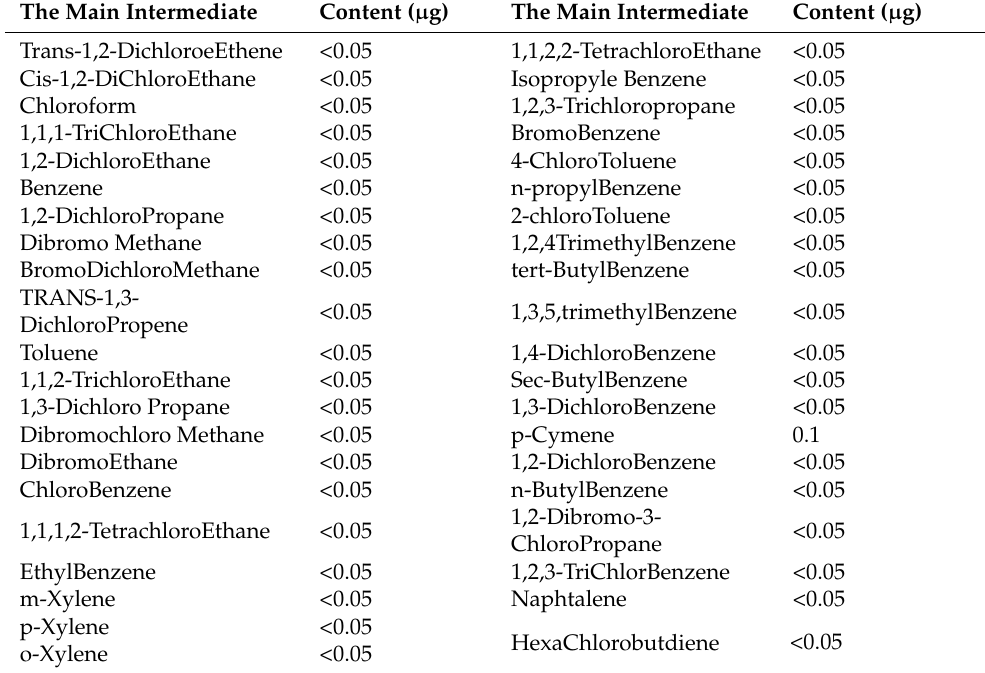
Table 1. The main compounds produced from the dye degradation using the sono-photocatalytic